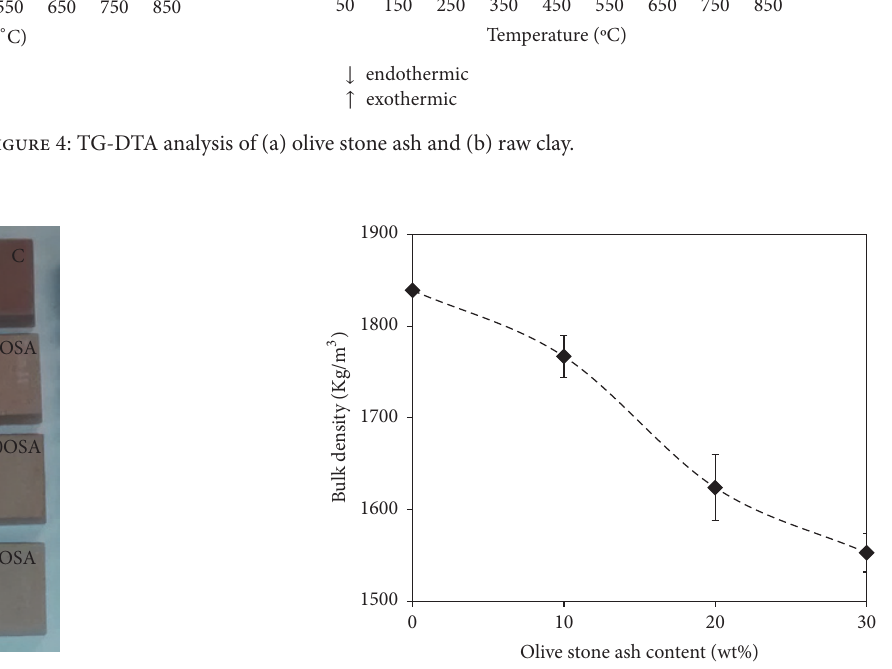
Figure 5: Bricks obtained by pressing of olive stone ash mixed with clay and fired at 900 ∘ C.